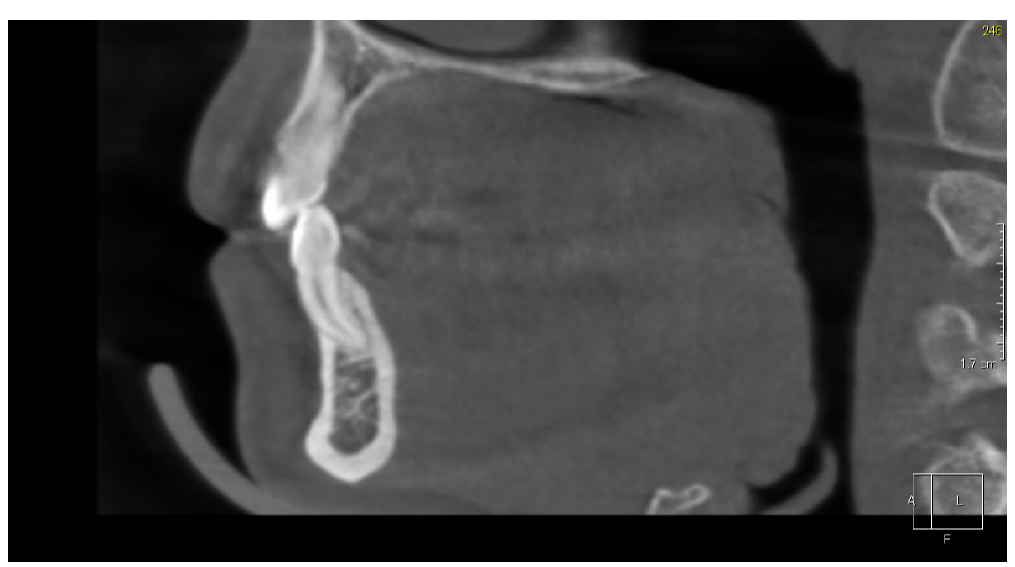
Figure 1. Patient 1. Lingual dilaceration of right mandibular canine (43)—Sagittal reconstruction from Cone Beam Computed Tomography (CBCT).